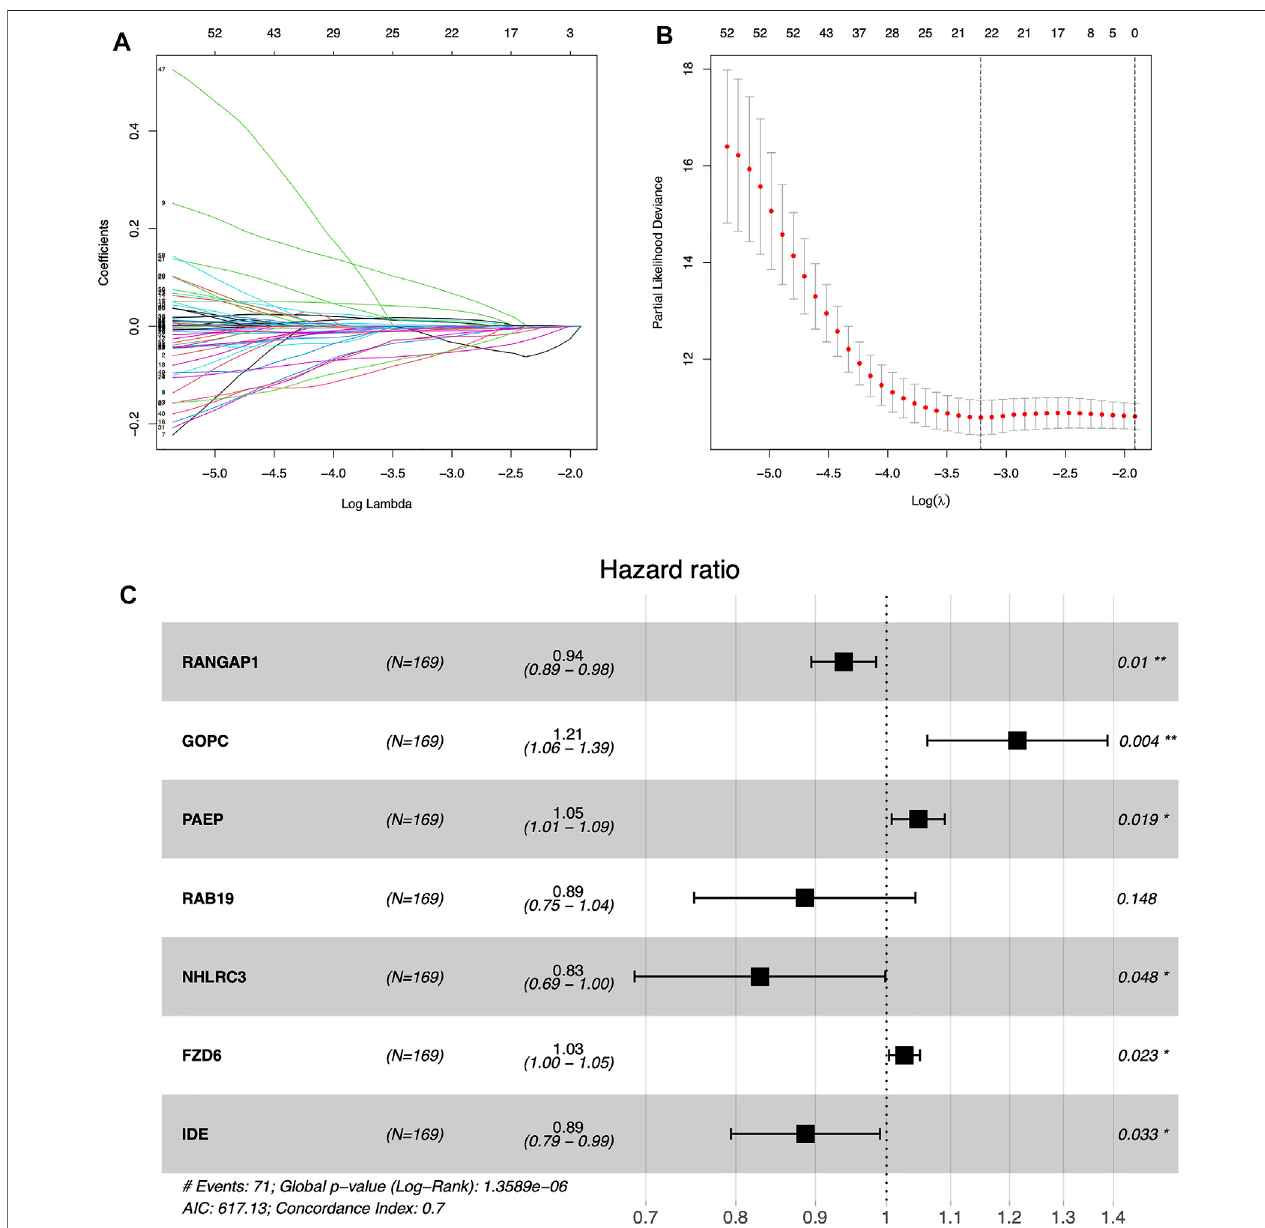
FIGURE3| EstablishingtheprognosticmodelbyLASSOregressionanalysis (A) LASSOcoef fi cientplot (B) Thetraininggroupcontainingthebestloglambdavalue (C) Forest map showing 95% con fi dence intervals and HR values.